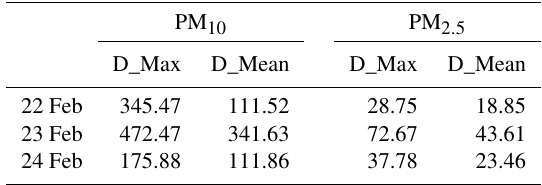
Table 1. Observed PM 10 and PM 2 . 5 concentrations (µgm − 3 ) recorded on each day of an Asian dust event in February 2015. The values are averaged of the 20 AQMS sites shown in Fig. 2. D_Max denotes daily maximum concentrations and D_Mean daily mean concentrations. PM